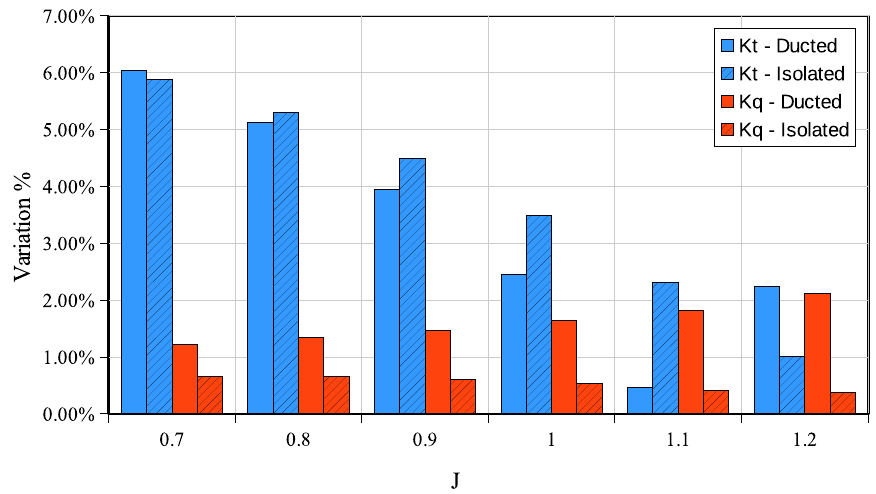
Figure 6. Percentage variation (pushing with respect to pulling condition) of the thrust and torque coefficients varying the shaft direction.